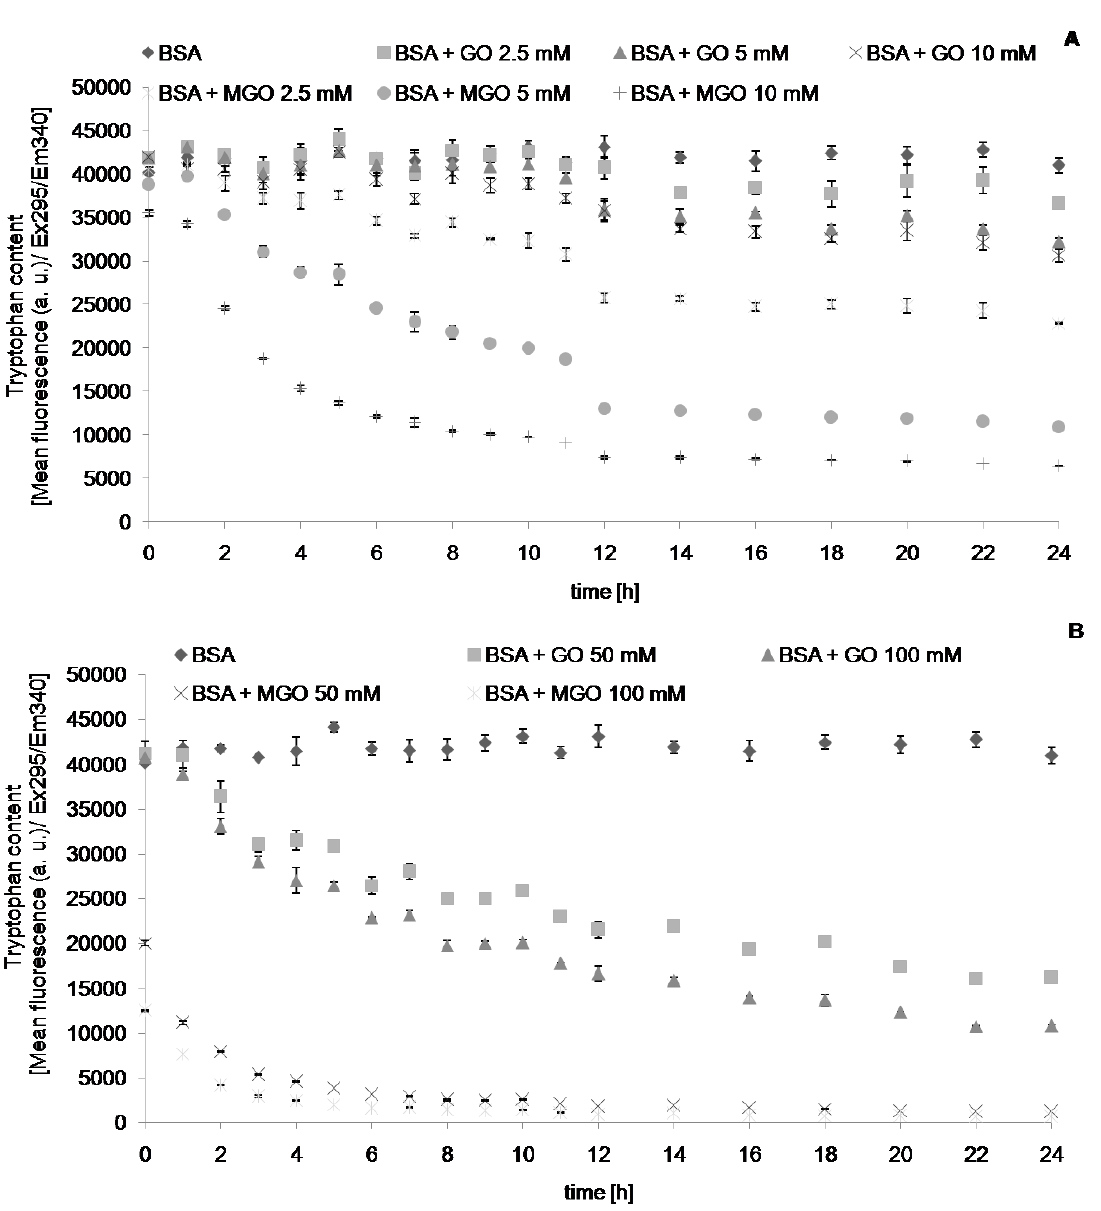
Figure 5. The time course of tryptophan fluorescence during incubation of BSA (0.09 mM) with 2.5, 5 and 10 mM ( A ), and 50 and 100 mM ( B ) GO and MGO at 37